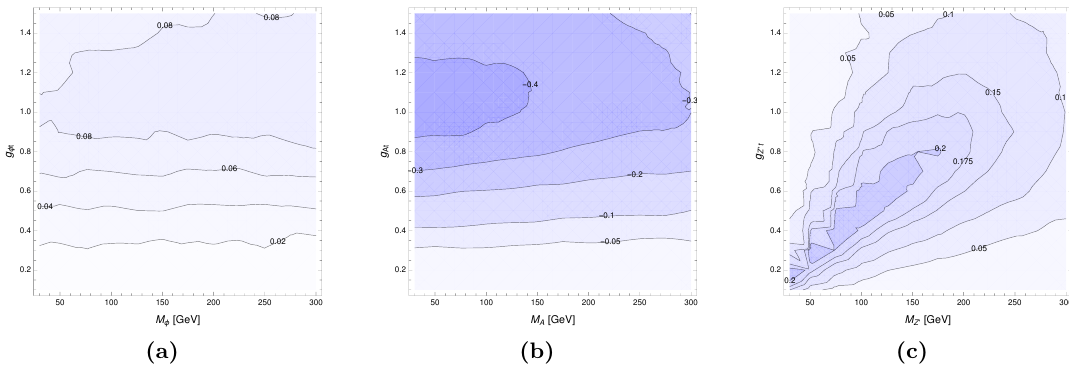
Figure 3. Fraction of the contribution to the total pp t (cid:22) tt (cid:22) t cross-section due to interference ! between SM (QCD+QED) and NP. It is important to stress that the interference is enhanced by including QED corrections, as discussed in text. In the Pseudo-scalar benchmark points the interference may reach up to 70% of the total SM LO cross-section. The interference for the (cid:24) (cid:0) Graviton benchmark points | not shown | is negligible in the relevant